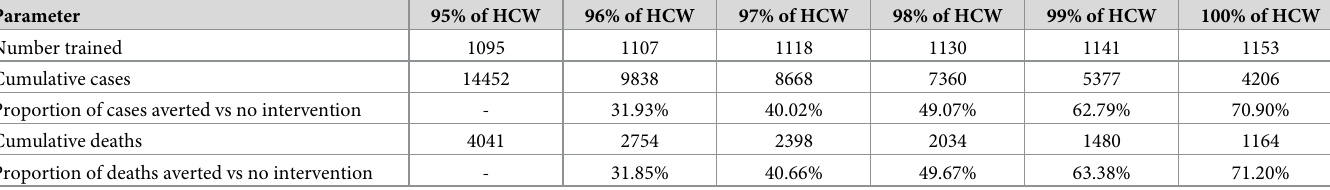
Fig 7. Impact of pre-deployment training of different proportions of HCWs on cumulative Ebola cases and deaths. A: Cumulative cases. B: Cumulative deaths. https://doi.org/10.1371/journal.pone.0254044.g007 Table 3. Impact of pre-deployment training for healthcare workers on cumulative cases and deaths among overall population caused by EVD.